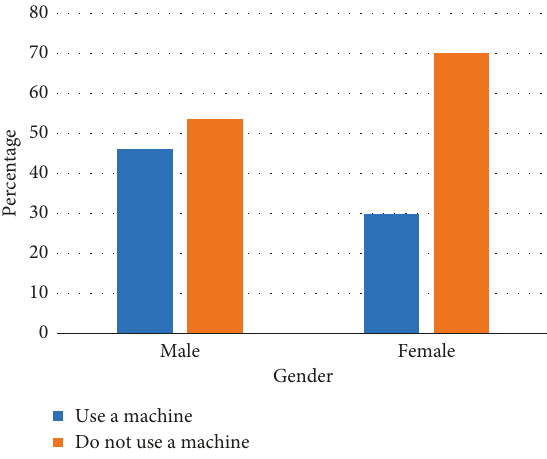
Figure 2: Association between gender and use of an automatic impression mixing machine. Table 4: Type of alloys used by the respondents for fixed